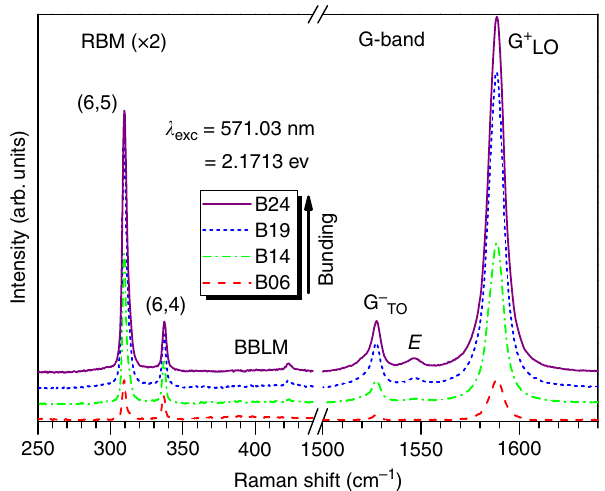
Fig. 1 Resonance Raman spectra as a function of degree of nanotube bundling. Example Raman spectra in the RBM (×2) and G-band regions collected on E S resonance (at ≈ 571 nm excitation) for the (6,5) SWCNTs. 22 Spectra are displayed for samples in which degree of SWCNT bundling is varied from least bundled (B06) to most bundled (B24). Speci fi c spectral features are labeled by their phonon mode designation. Curves are offset vertically for